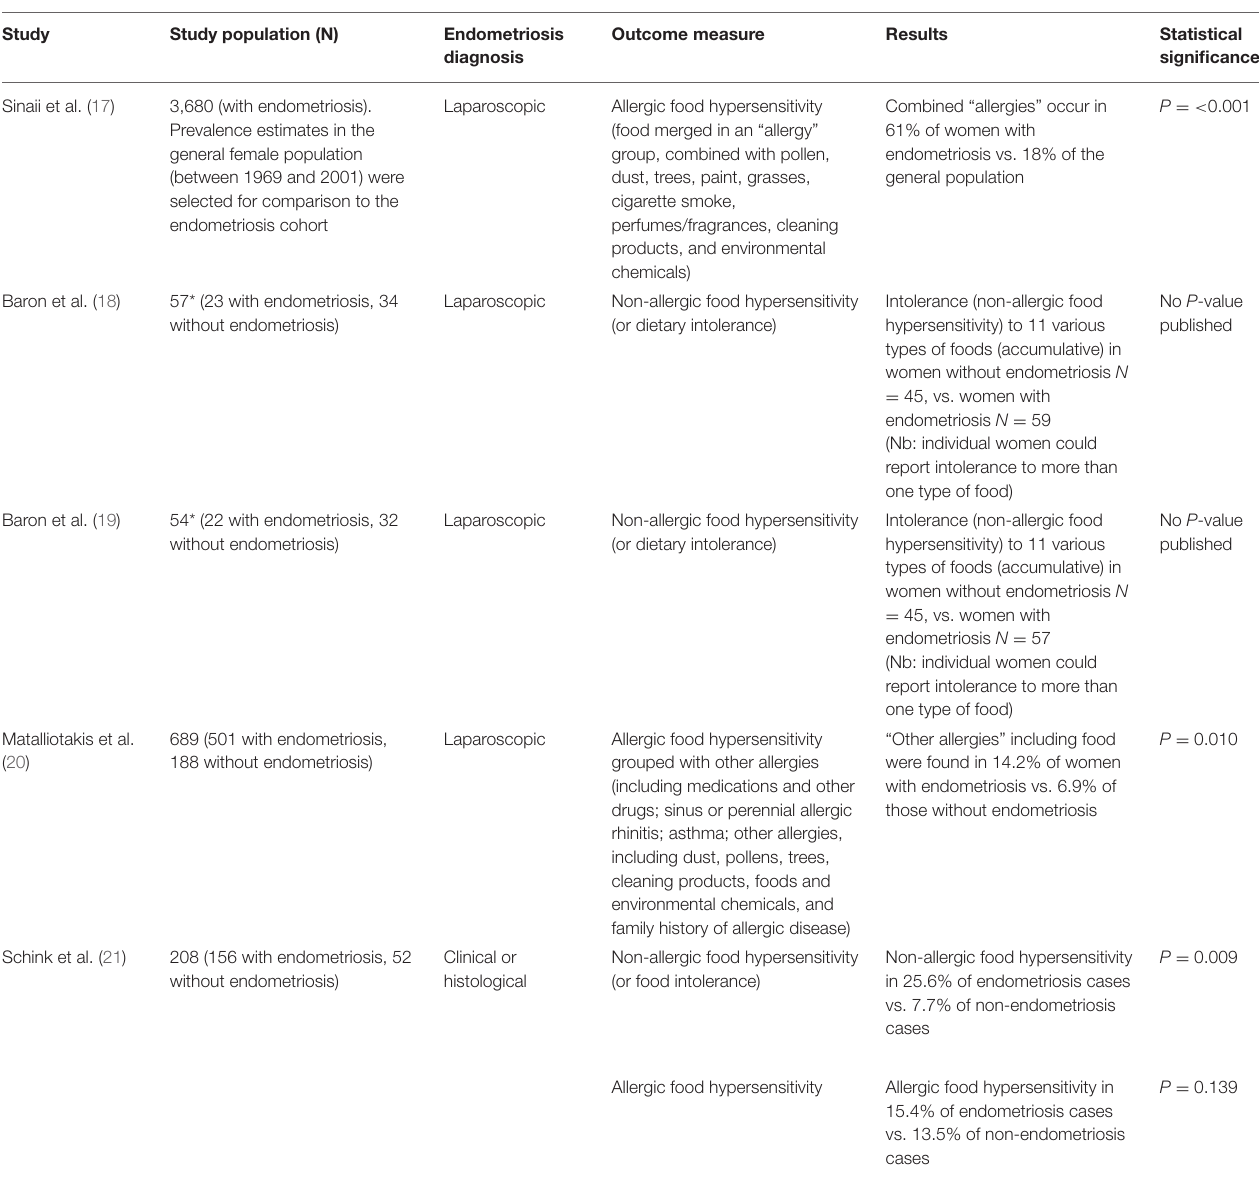
TABLE 1 | Summary of articles included in this